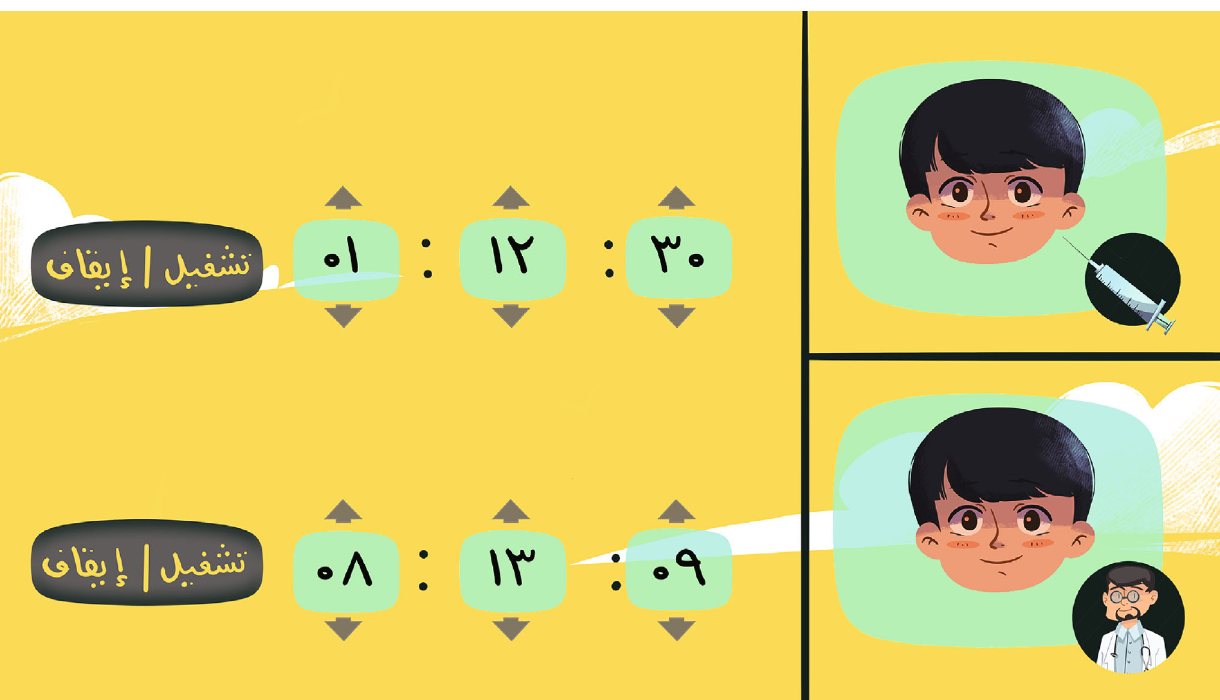
Figure 12: Reminder